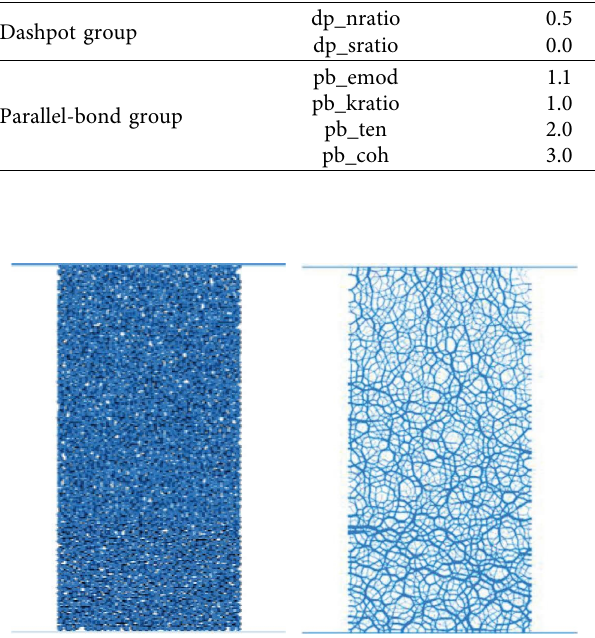
Figure 2: Te two-dimensional numerical model and contact model of the backfll